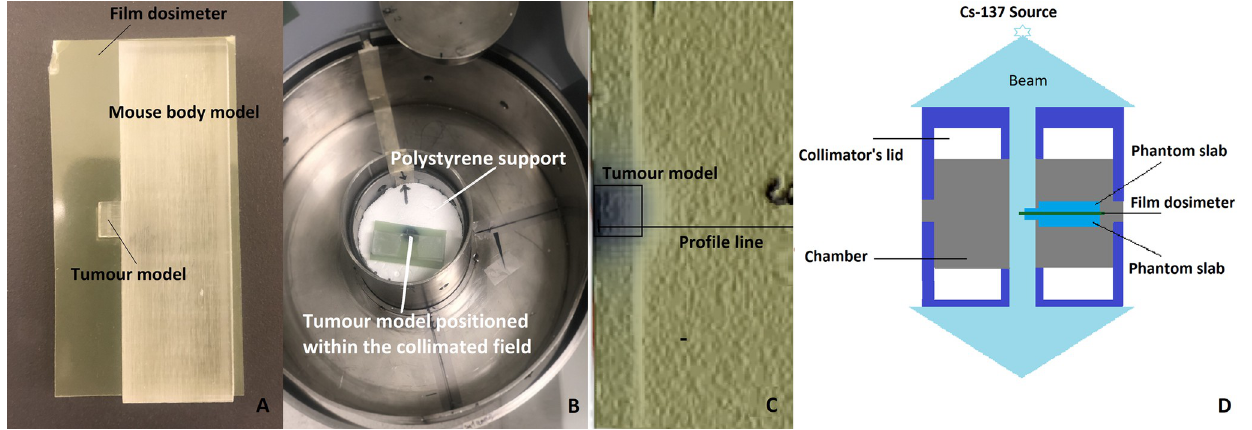
Fig 3. Illustration of the EBT3 film sandwiched between PMMA slabs and irradiation setup. A) The GAFchromic film dosimeter sandwiched between PMMA phantom slabs. B) The PMMA phantom was placed inside the collimator and the tumour model was situated within the marked collimated beam on the polystyrene platform for irradiation. C) The irradiated film from the phantom irradiation is shown. Irradiation field and profile line selection are marked. D) Cutaway drawing of the collimator with the PMMA phantom positioned at the midplane of the collimator and the film dosimeter sandwiched between phantom slabs irradiated with Cs-137 beam. Film dosimeter, phantom slabs, and the collimator’s components are